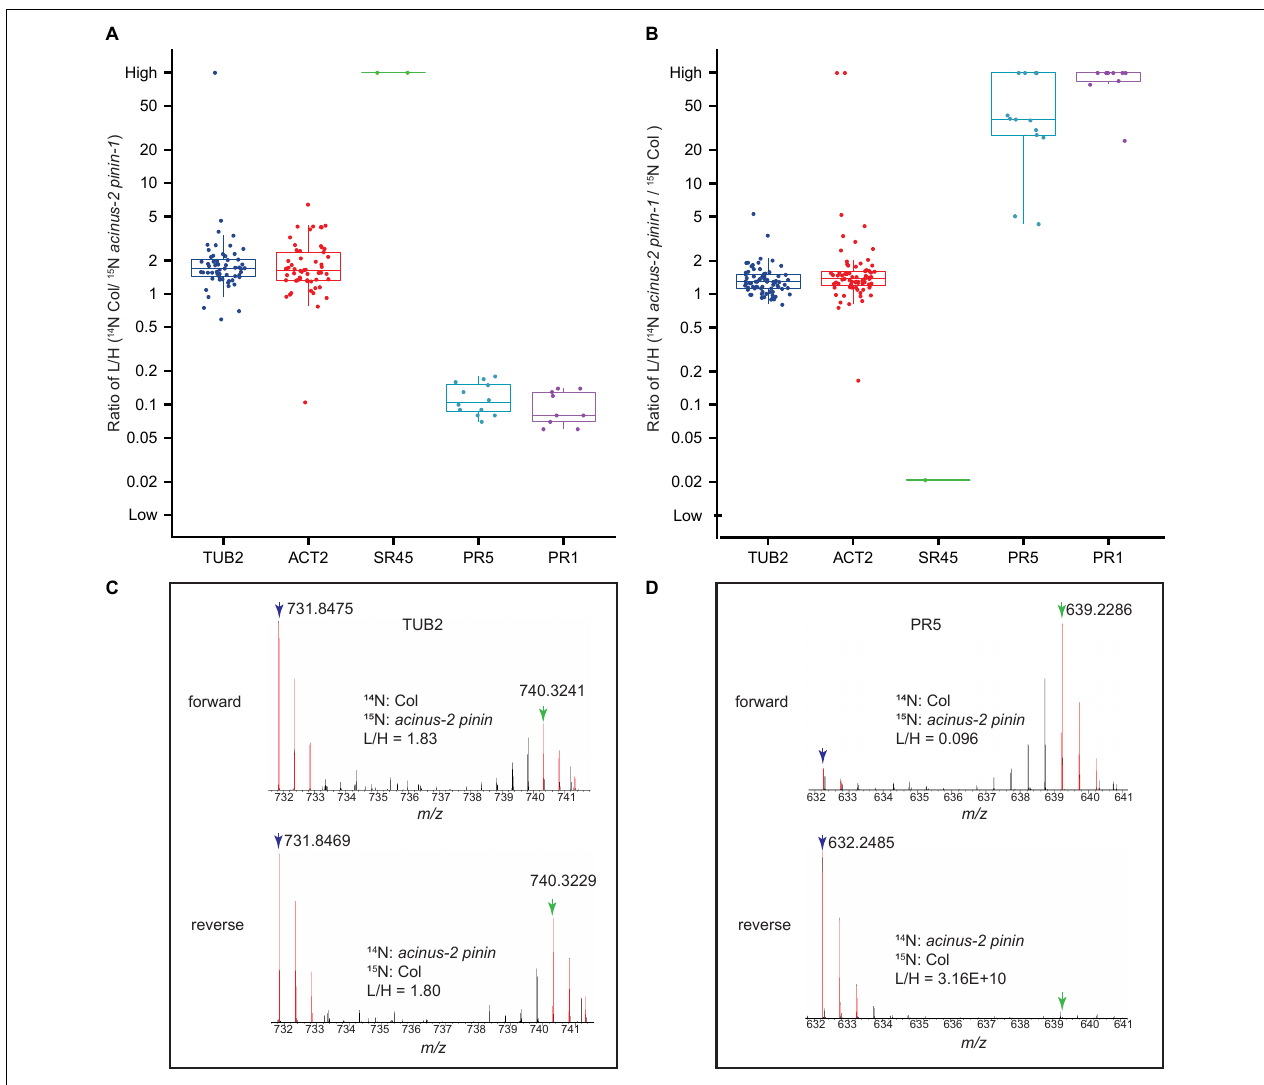
FIGURE 5 | Quantitative ratio of proteins in wild-type Col and acinus-2 pinin-1 double mutant before normalization. Each box plot shows the raw L/H labeled peptide ratios belonging to their appropriate protein as reported by Protein Prospector. (A,B) Boxplot with beeswarm shown in two reciprocal labeled samples, SR45 is dramatically decreased, while PATHOGENESIS-RELATED GENE 5 and 1 (PR5 and PR1) show increased protein level in acinus-2 pinin double mutant. TUBULIN 2 (TUB 2) and ACTIN 2 (ACT2) are used as control. Three data points (a lower quartile (25%), median, and upper quartile (75%) are displayed in the output. Each dot is one peptide quantification. (C,D) MS1 spectra of the peptide “EVDEQMLNVQNK” from TUB2 and “FNTDQYCCR” from PR5 protein. Blue arrow: 14 N labeled M peak; green arrow: 15 N labeled M peptide. PR5 shows a significant increase in the double mutant. In the forward experiment, the 15 N labeling efficiency is about 94%, while reverse labeling is about